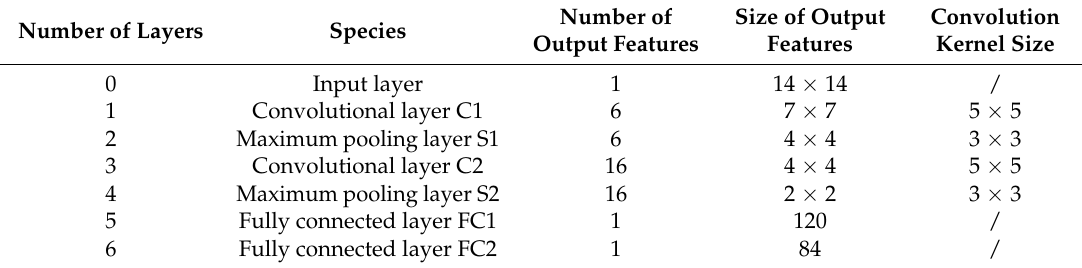
Table 4. Maximum overlap pooling CNN parameter table.